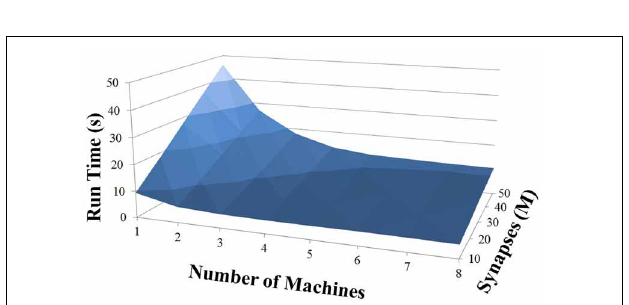
FIGURE 12 | LIF neuron model: 10s simulation.